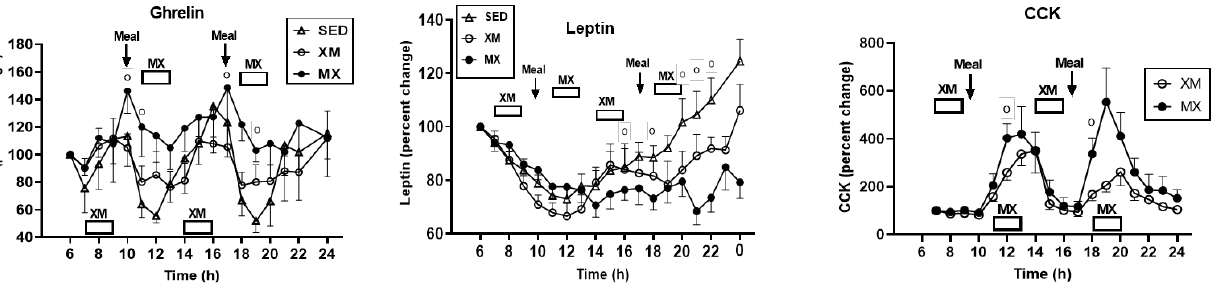
Figure 13. Exercise- and meal-timing effects on plasma ghrelin, leptin, and CCK concentrations. Circle superscripts identify time slices when group differences were significantly different. XM = exercise before meals, MX = exercise before meals, SED = sedentary group.